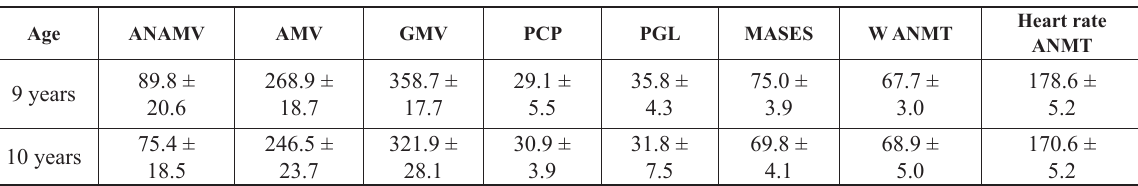
Table. Indicators (X ± σ) of body reserve opportunities for y oung gymnasts